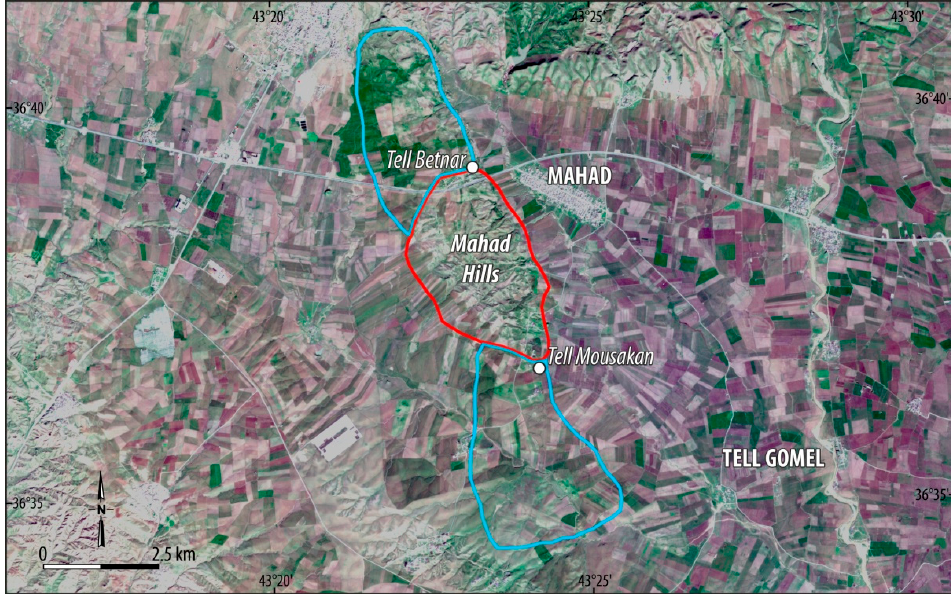
Figure 16. Other parts of the Mahad hills to be inspected. Background image © EU ‐ Sentinel. CC234 (TC). 10 January 2019 .